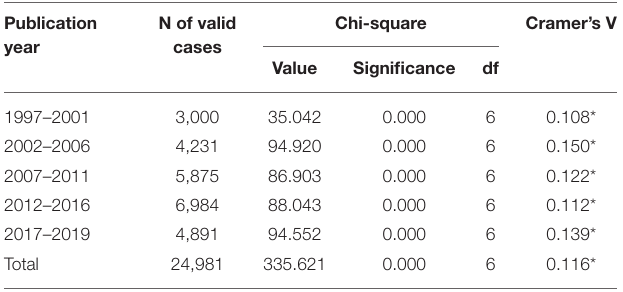
TABLE 3 | Chi-square and Cramer’s V statistics comparing author gender by year